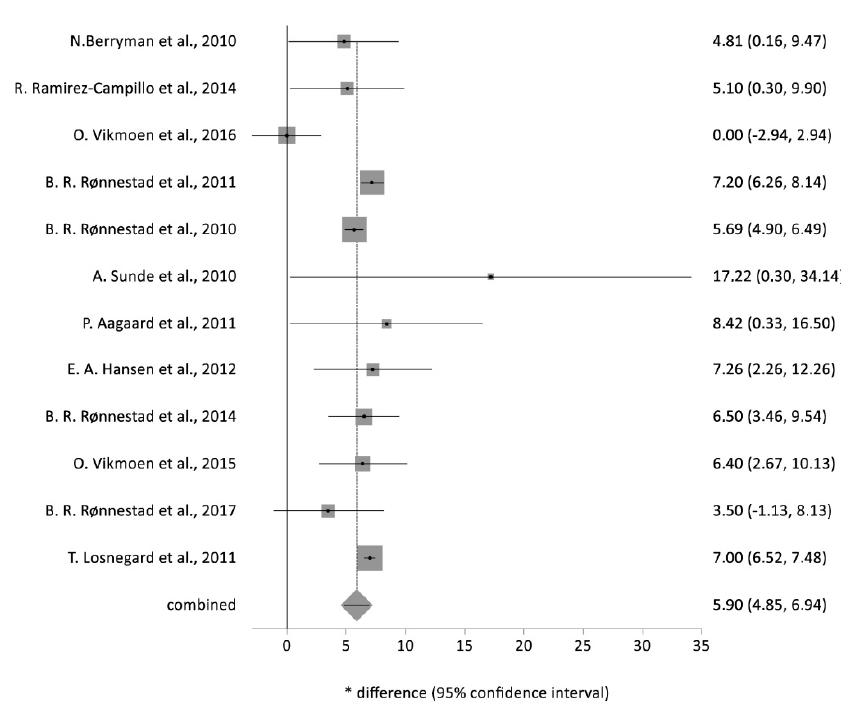
Figure 3. Forest plot of the studies included in the meta-analysis for endurance performance: forest plot with effects size and 95% confidence interval of every study included in the statistical analysis and combined effect size, representing the effect of the intervention protocol (nonspecific strength training) on the endurance performance (time trial or time trial to exhaustion). Cochran Q = 33.1 (df = 11) p = 0.0005; moment-based estimate of between studies variance = 1.3; I2 (inconsistency) = 66.7% (95% CI = 28.1% to 80.4%); random effects (Der Simonian–Laird) pooled * difference = 5.9 (95% CI = 4.8 to 6.9); Z (test * difference) = 11 p < 0.0001.